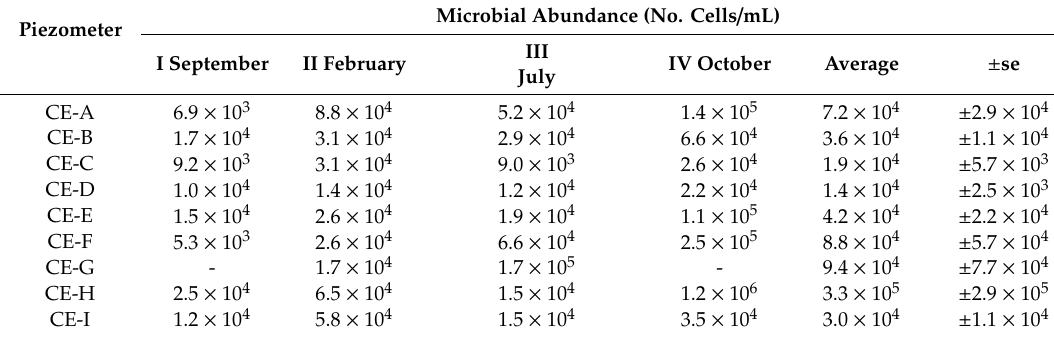
Table 7. Microbial abundance (No. Cells / mL) values determined in each piezometer (CE-A, CE-B, CE-C, CE-D, CE-E, CE-F, CE-G, CE-H, and CE-I) at each sampling campaign. Piezometer